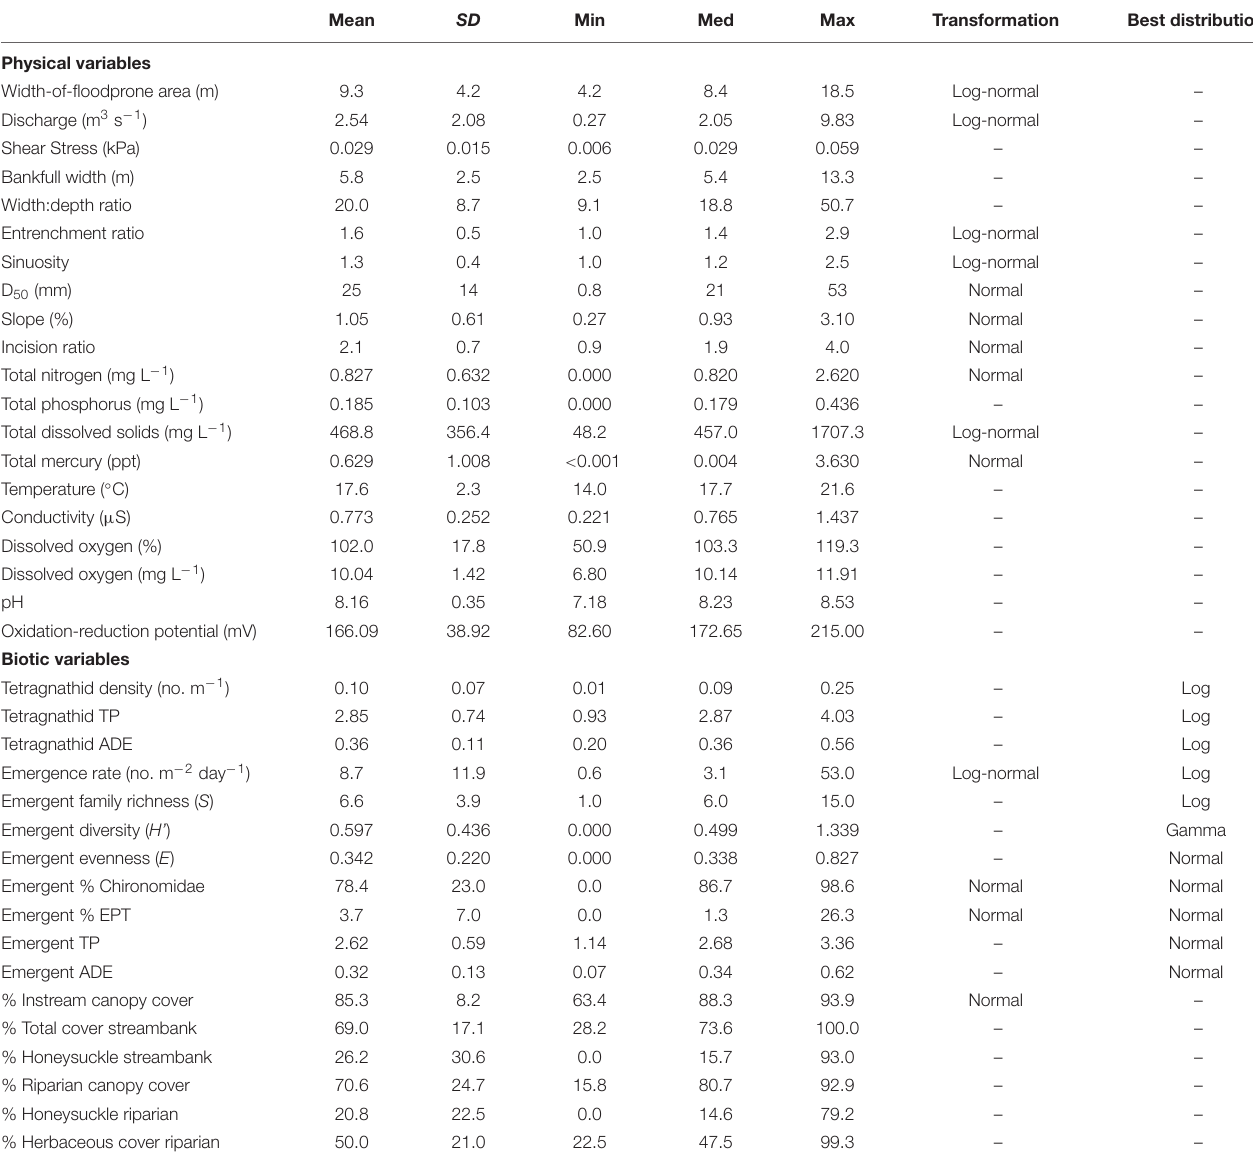
TABLE 1 | Descriptive statistics for all physical and biotic variables included in the analysis, including mean, standard deviation (SD), minimum (Min), median (Med), and maximum (Max). Mean SD Min Med Max